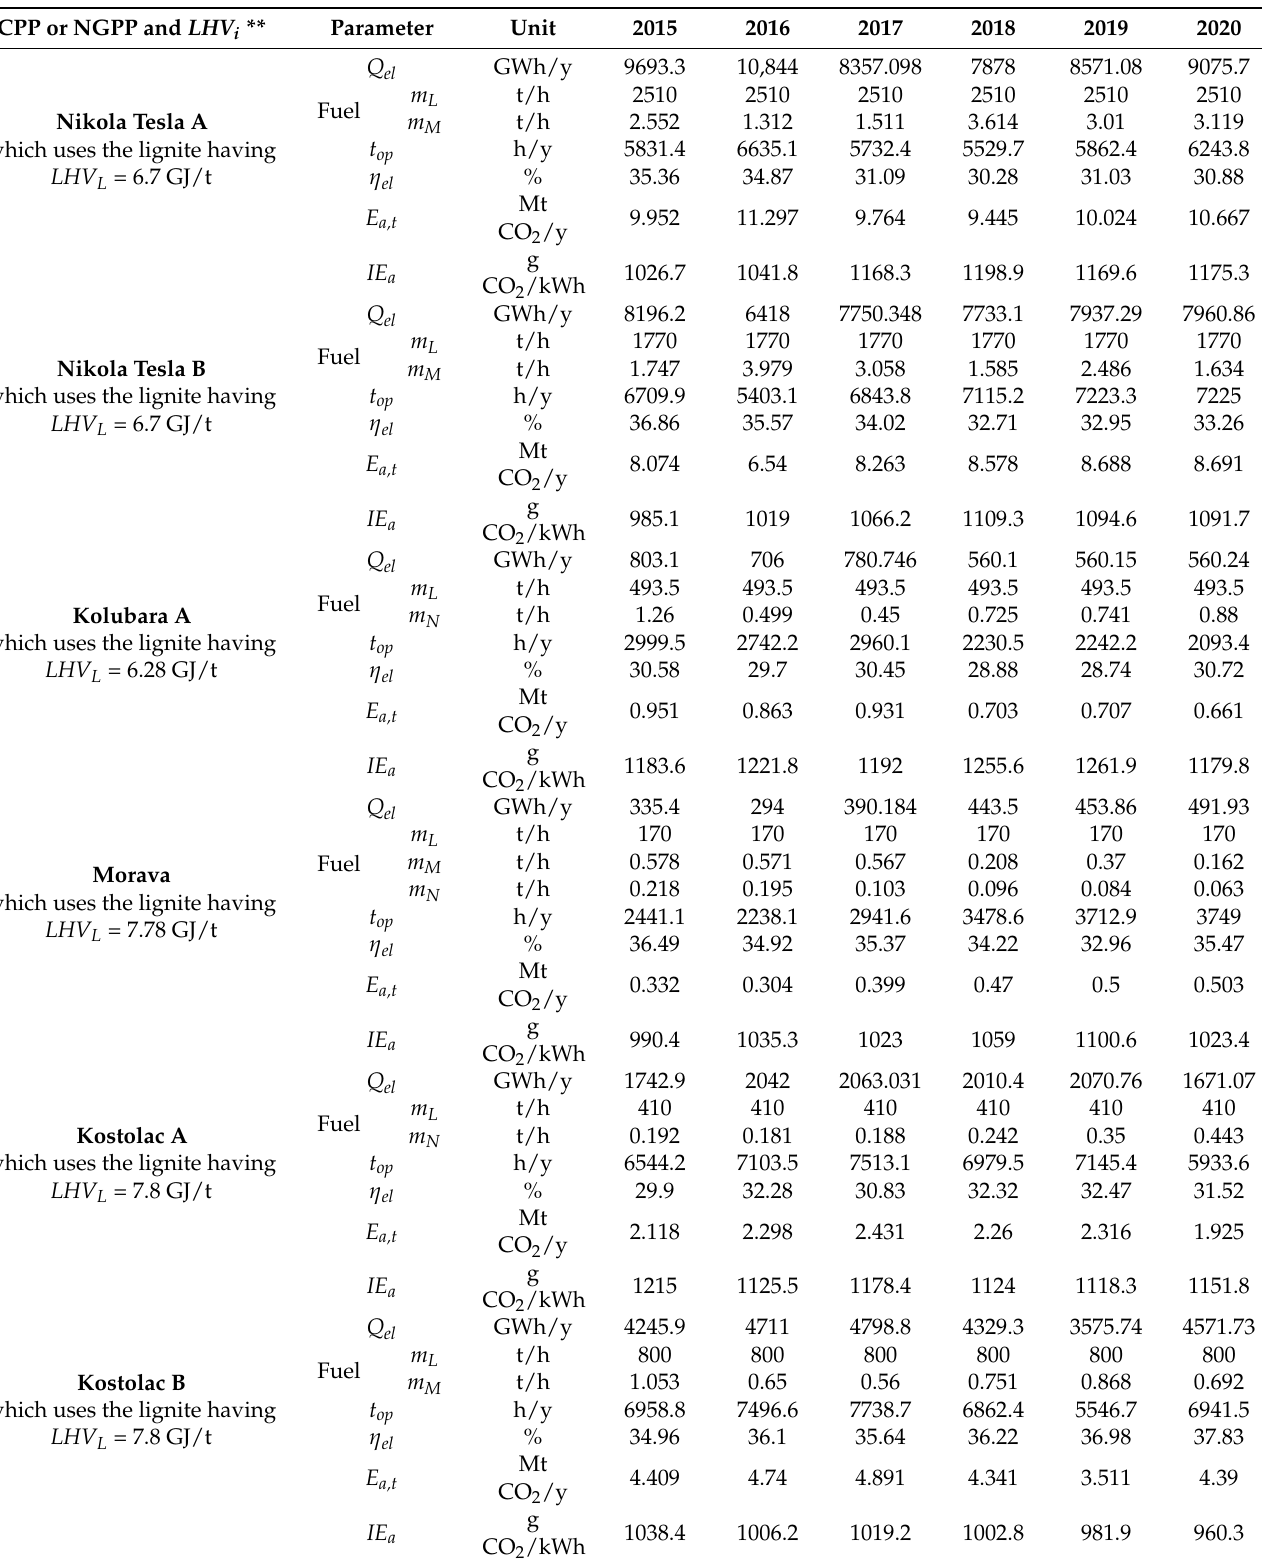
Table A1. A periodic overview of the actual performance indicators, estimated annual CO 2 emissions, and estimated annual CO 2 emission intensities for Serbian CPPs and NGPPs built before 2000 [6]